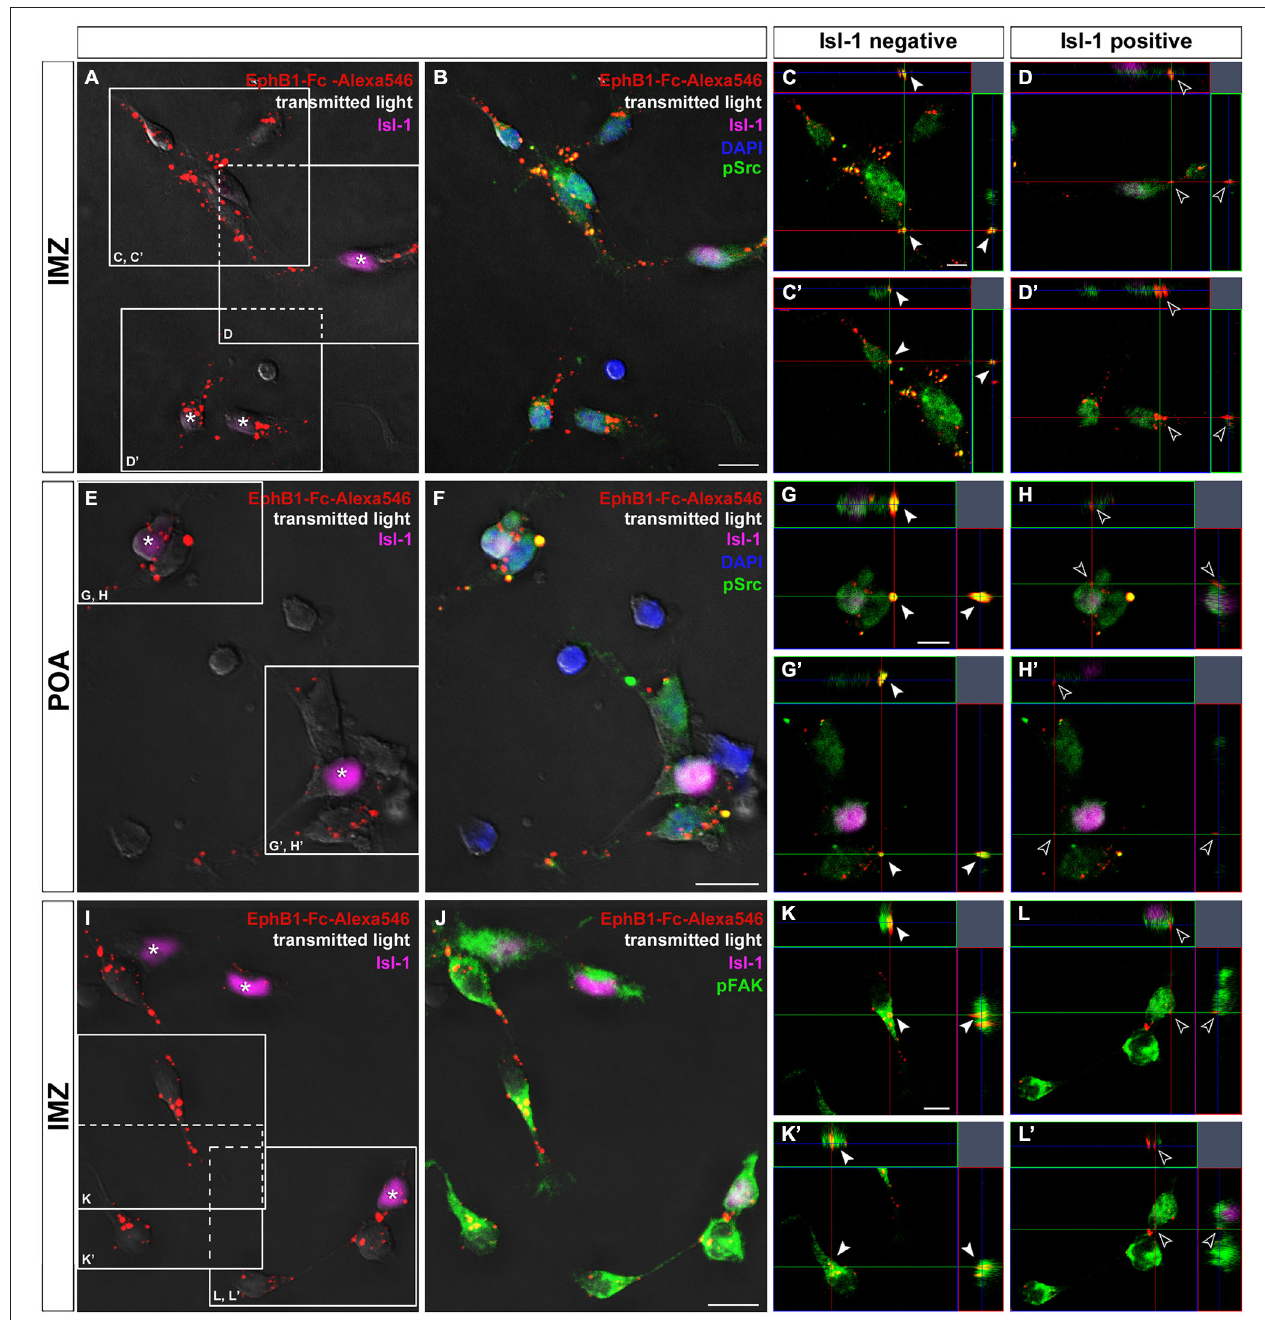
negative neurons (arrowheads in C,C’; G,G’ ) while Isl-1 expressing cells (asterisks) show no or only weak Src activation as the merged image forms nearly no yellow signal (hollow arrowheads in D,D’; H,H’ ). The same result was found for co-localization of EphB1-Fc binding sites and pFAK signals, exemplarily shown for cells from the IMZ ( I–L’ ). Scale bars: (B,F,J) 10 µ m; (C,G,K) 5 µ